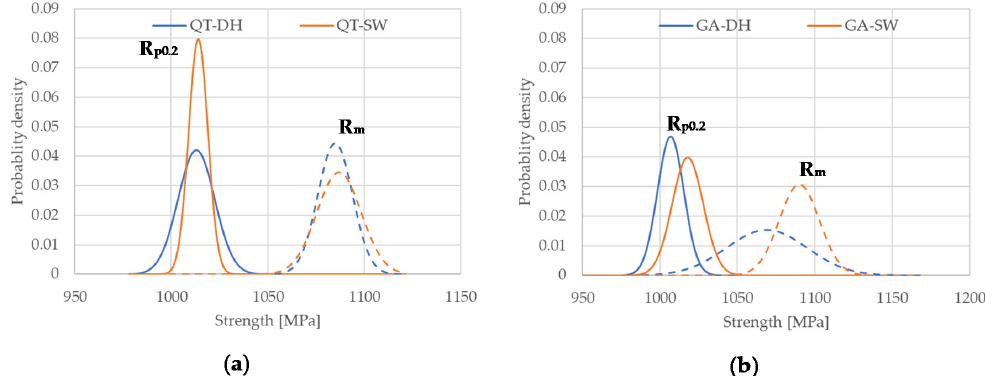
Figure 12. Probability density plot assuming Normal distribution of average strengths and their uncertainties in Table 7 as mean and standard deviation values. ( a ) Plot for the QT specimens. ( b ) Plot for GA specimens.